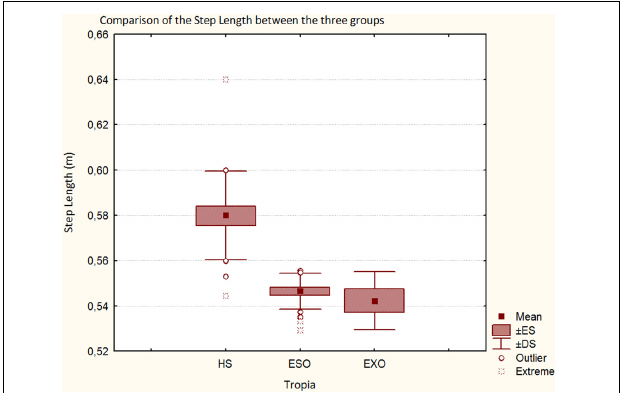
FIGURE 3 | Step width in HS, in patients with ESO and in patients with EXO.